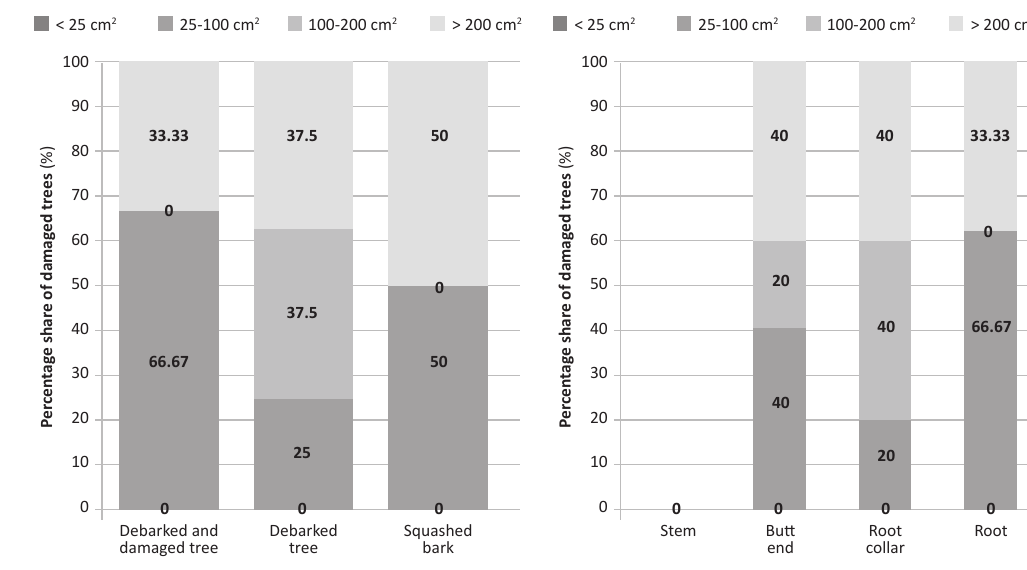
Debarked and damaged tree